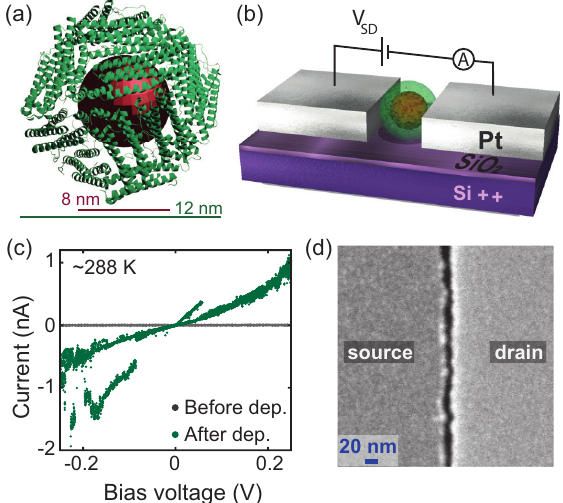
Figure 1. ( a ) Schematic representation of ferritin, based on the protein data base (PDB) of horse- spleen apoferritin (PDB ID: 2W0O [29]). The organic shell is in green; the mineral core occupying the internal cavity is in red. ( b ) Schematic circuit of a device containing one ferritin particle. ( c ) Electrical characterization of device A1 before (grey curve) and after (green curve) ferritin deposition, measured at room temperature, in vacuum. The grey curve indicates an open circuit, reflecting an empty device. The increase in current shown in the green curve indicates the capture of ferritin. In both cases, the current is measured by sweeping the voltage from negative to positive values, followed by sweeping from positive to negative values. ( d ) Scanning electron microscopy image of an empty device showing the gap of 9–19 nm size between source and drain